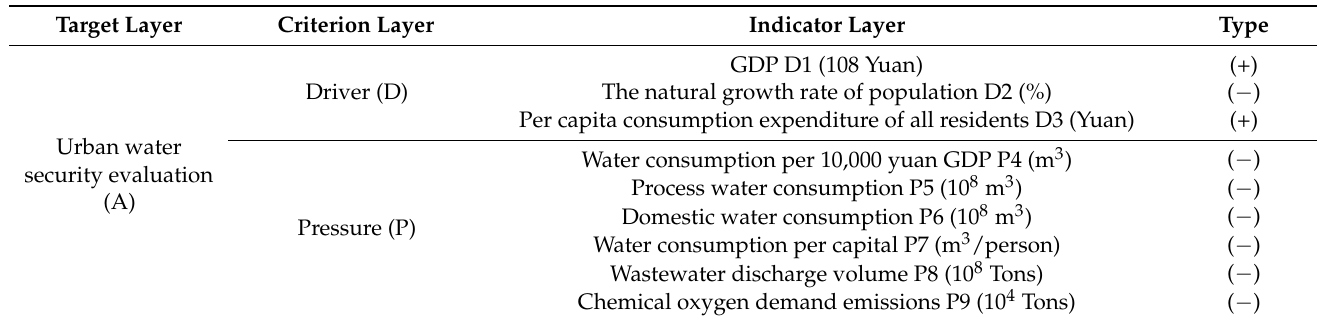
Table 1. The DPEBLR evaluation index system for urban water